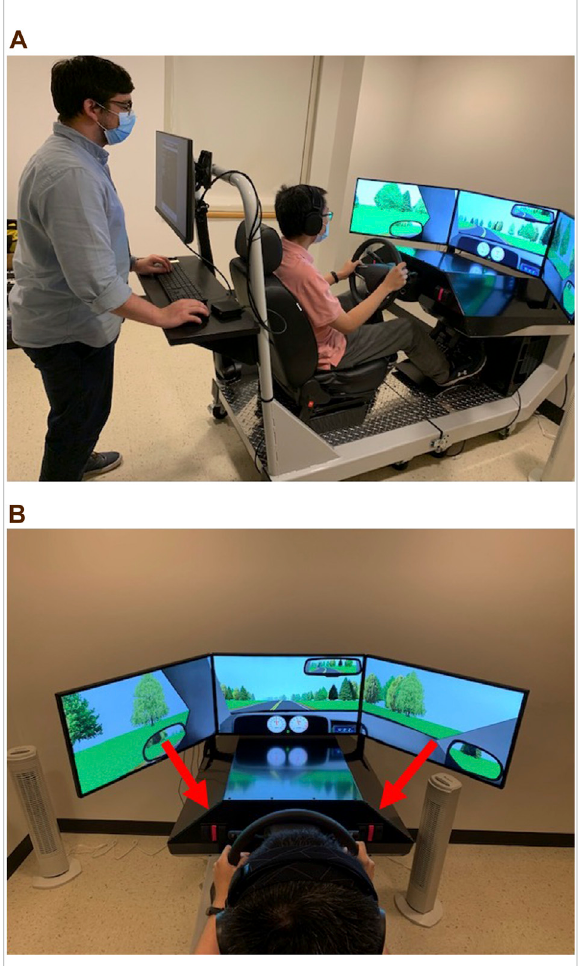
FIGURE 2 STISIM M40000-R Drive driving simulator with a sample driving scenario. (A) depicts the operator interface where session administrators(left)setpreselecteddrivingscenarios. (B) illustrates the three-screen display and arrows indicate the divided attention task ’ s buttons (pink